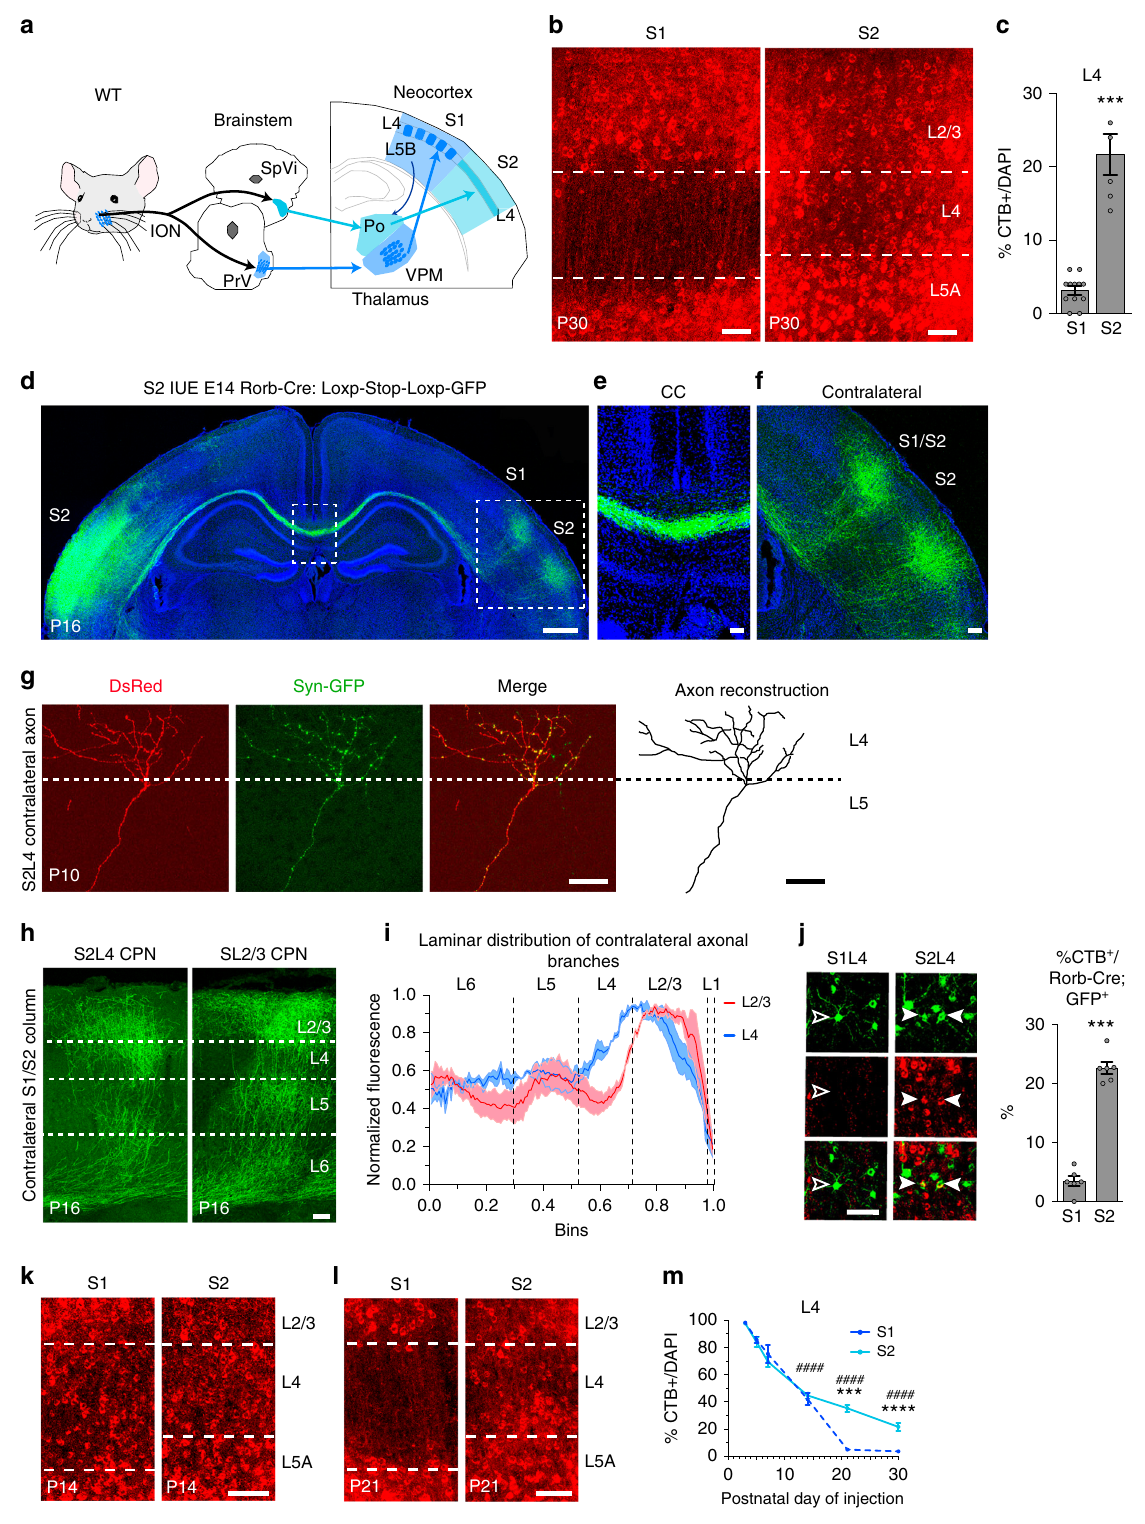
(Fig. 5h, i). Thus, S2L4 neurons integrate into speci fi c interhemi- spheric circuits that are distinct from those formed by SL2/3 neurons. Quanti fi cations of CTB + neurons in S1 and S2 GFP + neurons after CC injections at P30 of Rorb-Cre-electroporated animals demonstrated that GFP + contralateral branches originate from a neuronal subpopulation located almost exclusively in S2L4 (Fig. 5j, Supplementary Fig. 4d). Interestingly, analysis of